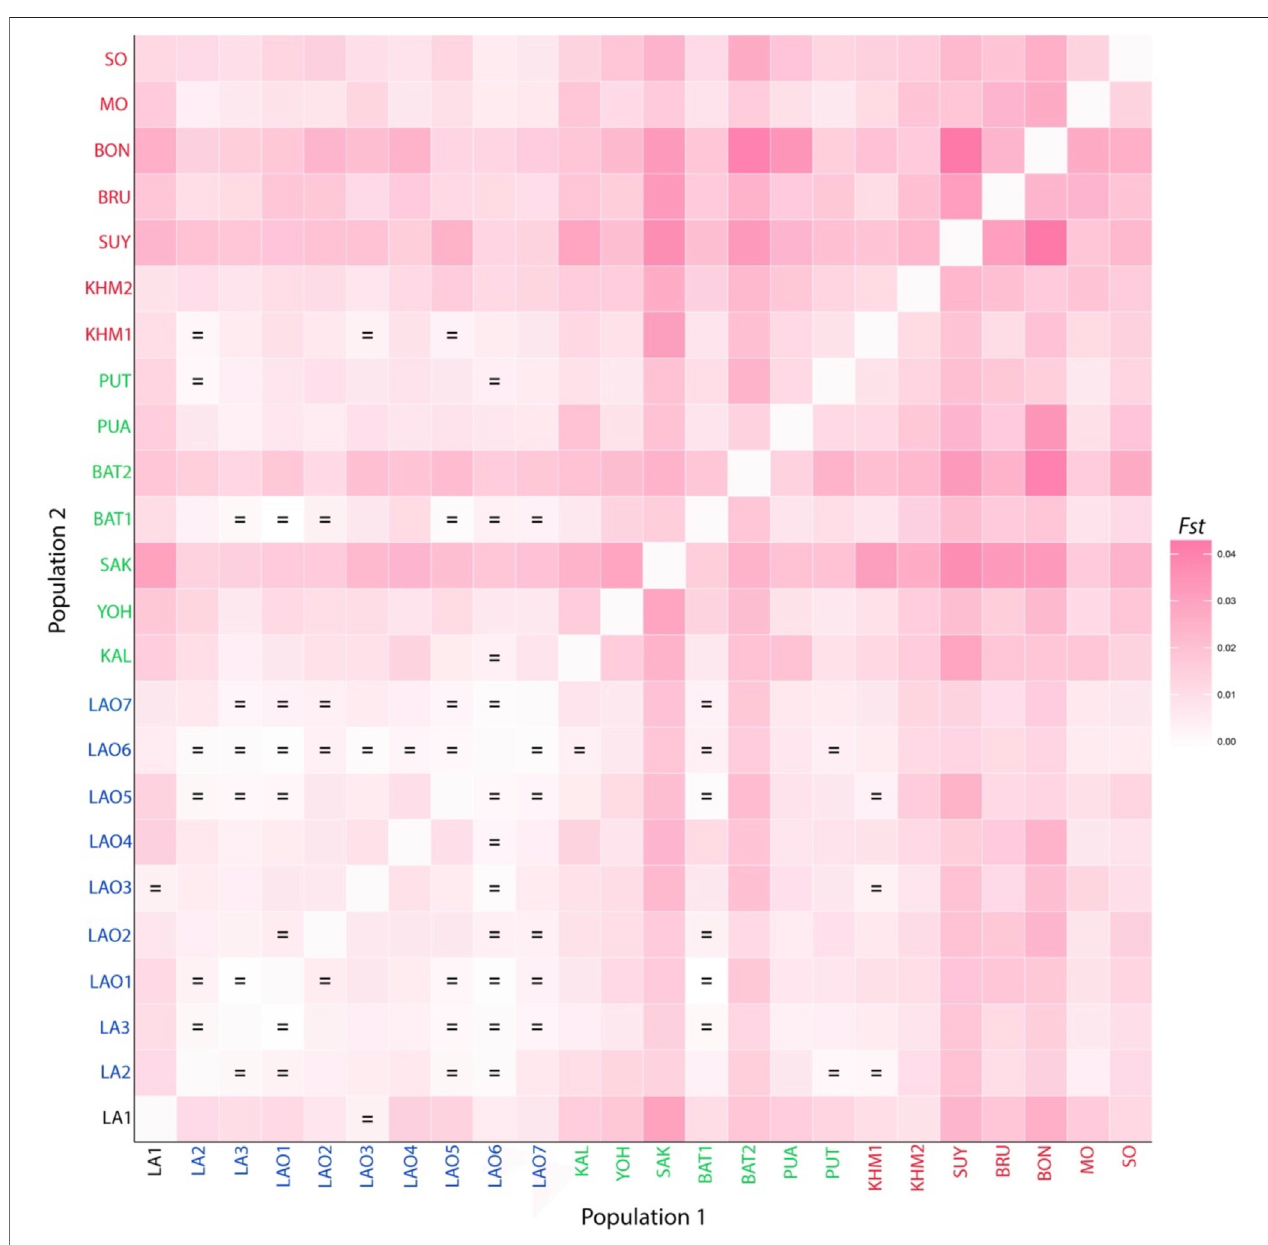
FIGURE5| Heatplot of F st values between 24populations from Laosand Thailand. Population names are color-coded asblack, blue, green and red representing AA-speaking Laotian, ethnic Lao group, compared TK-speaking and AA-speaking populations, respectively. The “ = ” symbol indicates F st values that are not signi fi cantly different from zero ( p >